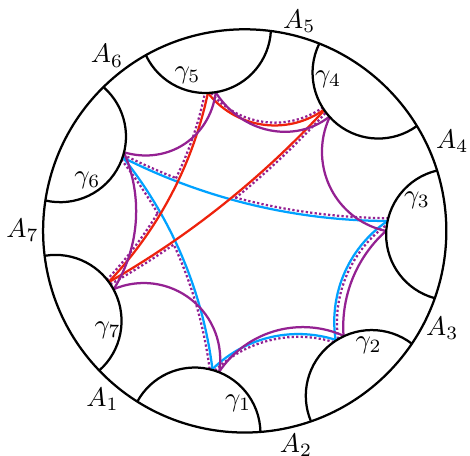
Figure 3 . A partition of n = 7 boundary subregions into n 1 = 3 sets of subregions and n 2 = 4 sets of subregions. The surface P 1 , which computes the tripartite entanglement of puri(cid:12)cation for the set C 1 = f A 1 A 2 A 3 A 4 ; A 5 ; A 6 A 7 g , is shown in red, and the surface P 2 , which computes the quadripartite entanglement of puri(cid:12)cation for the set C 2 = f A 2 ; A 3 ; A 4 A 5 A 6 ; A 7 A 1 g , is shown in blue. Segments of these two surfaces form the polygon (cid:22) P , shown with the dashed purple line, which can be deformed to the 7-partite entanglement wedge cross section (shown in solid purple). and partitioning 7 as 2 + 2 + 3, we